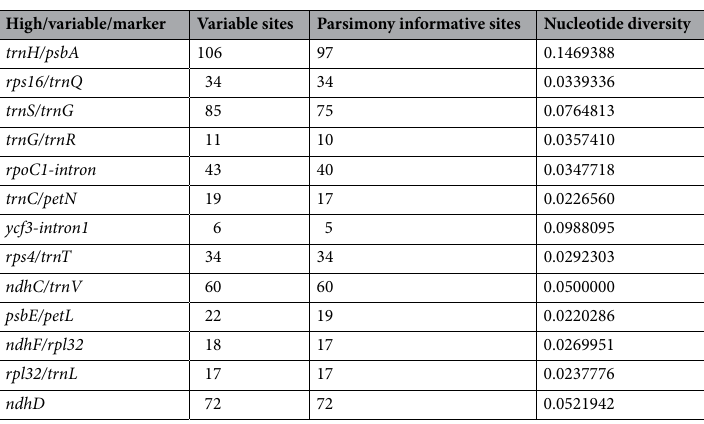
Table 3. High variable marker of cp genomes among 15 Ulmus